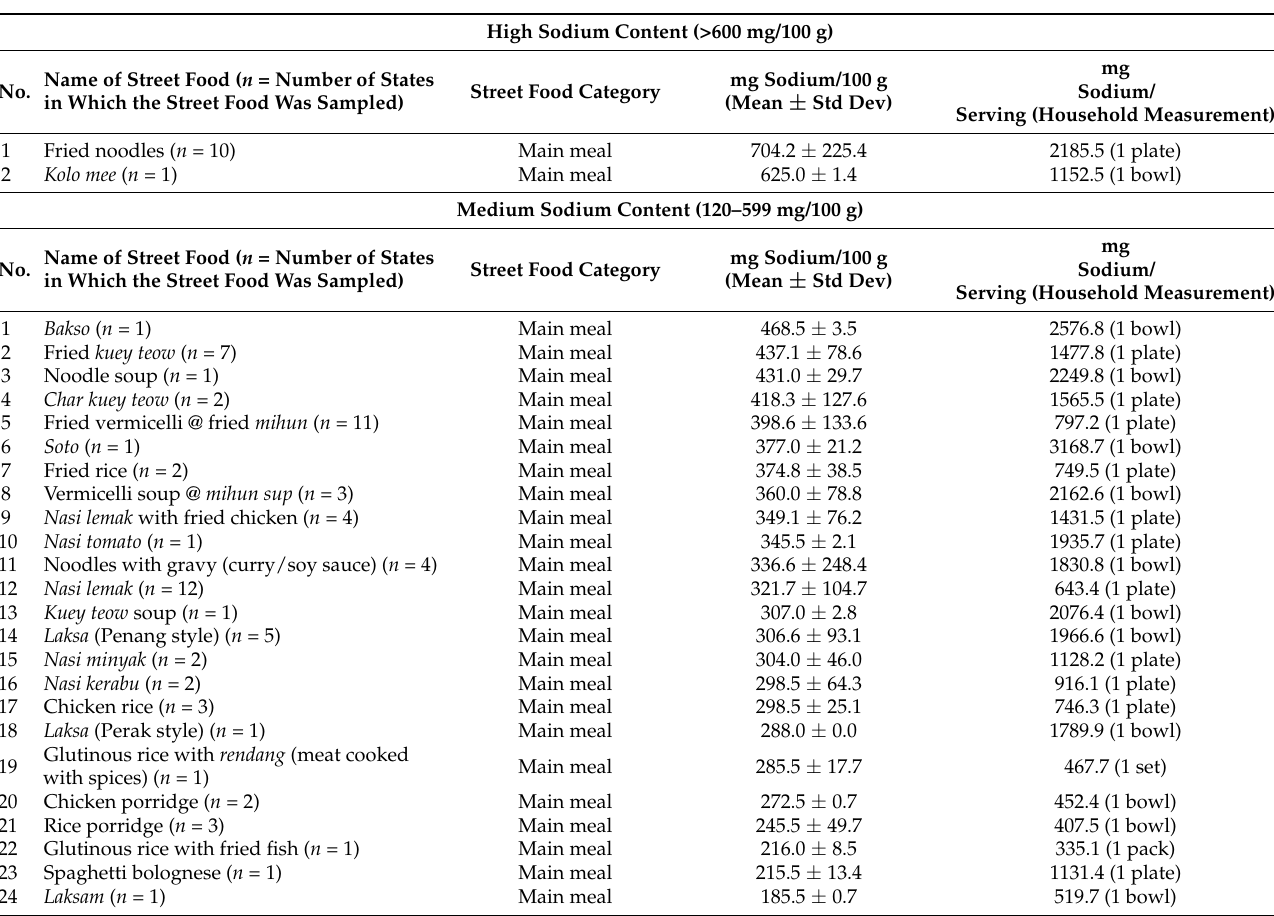
Table 4. Sodium content in noodle and rice-based street food with high (>600 mg/ 100 g sample) and medium (120–599 mg/100 g sample) sodium contents.